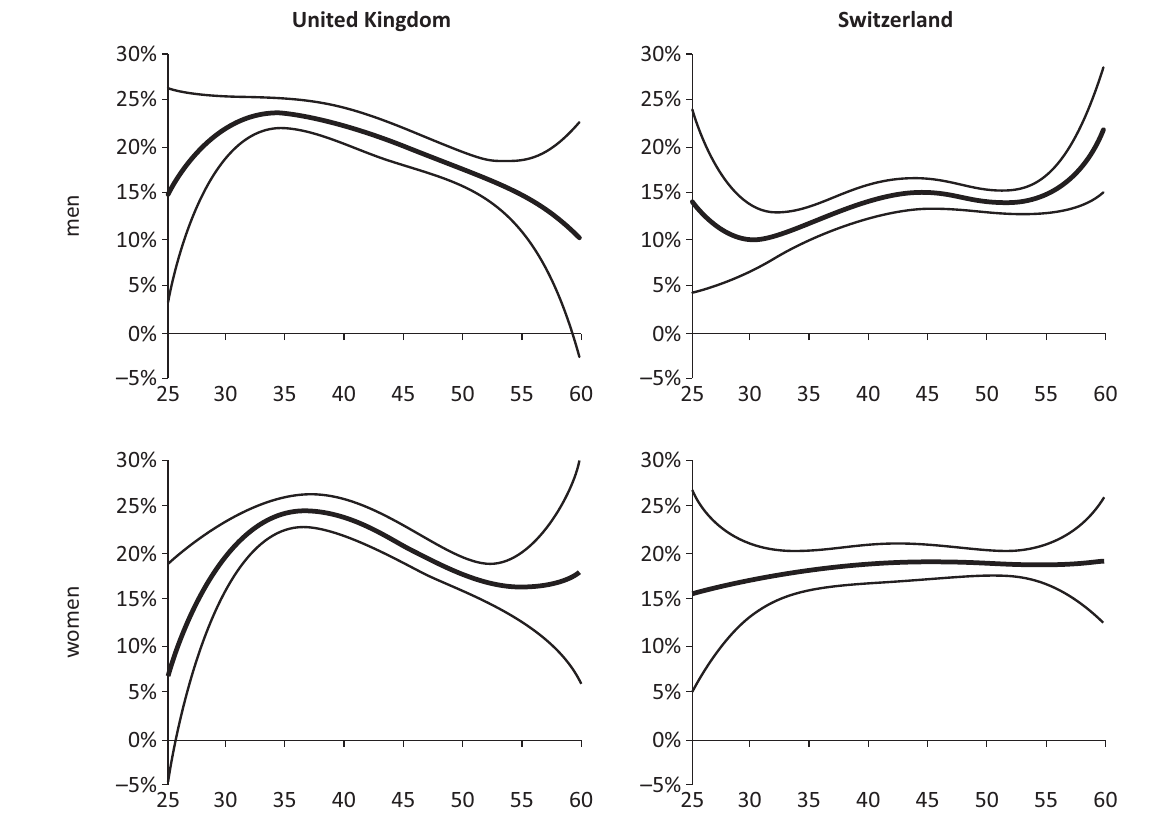
Figure 4. Difference in hourly wage by age for upper-secondary vocational education relative to lower education (aver- age marginal effects). Source: UK Labour Force Survey 1993–2014 and Swiss Labour Force Survey 1991–2014, cohort 1954–1968. Note: Main line stands for average marginal effect, thinner lines stand for 95% confidence